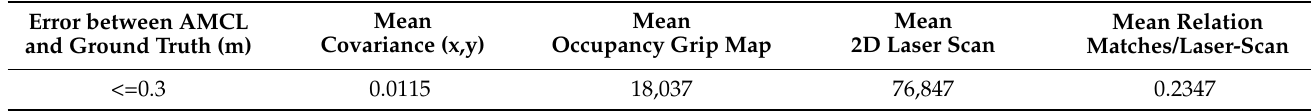
Table 6. Relationship between the ATE, covariance in x and y, and matches of occupied grid cells and 2D laser scan points in the truck